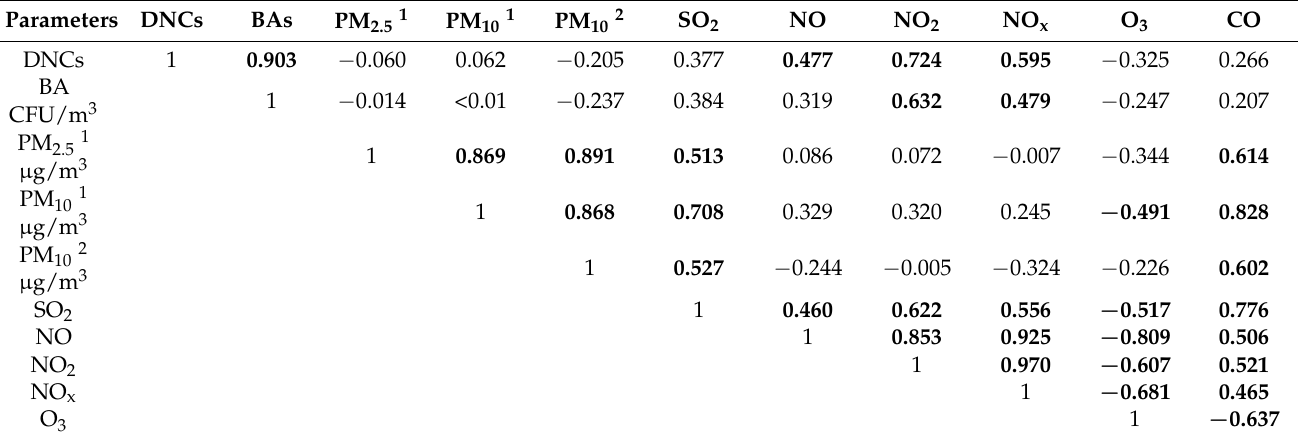
Figure 4. Contribution of Air Quality Index (AQI) during March 2021 in Gliwice. Table 2. Correlation matrix for SARS-CoV-2 daily new cases (DNCs), bacterial aerosol concentrations, and ambient air pollution levels during March 2021.